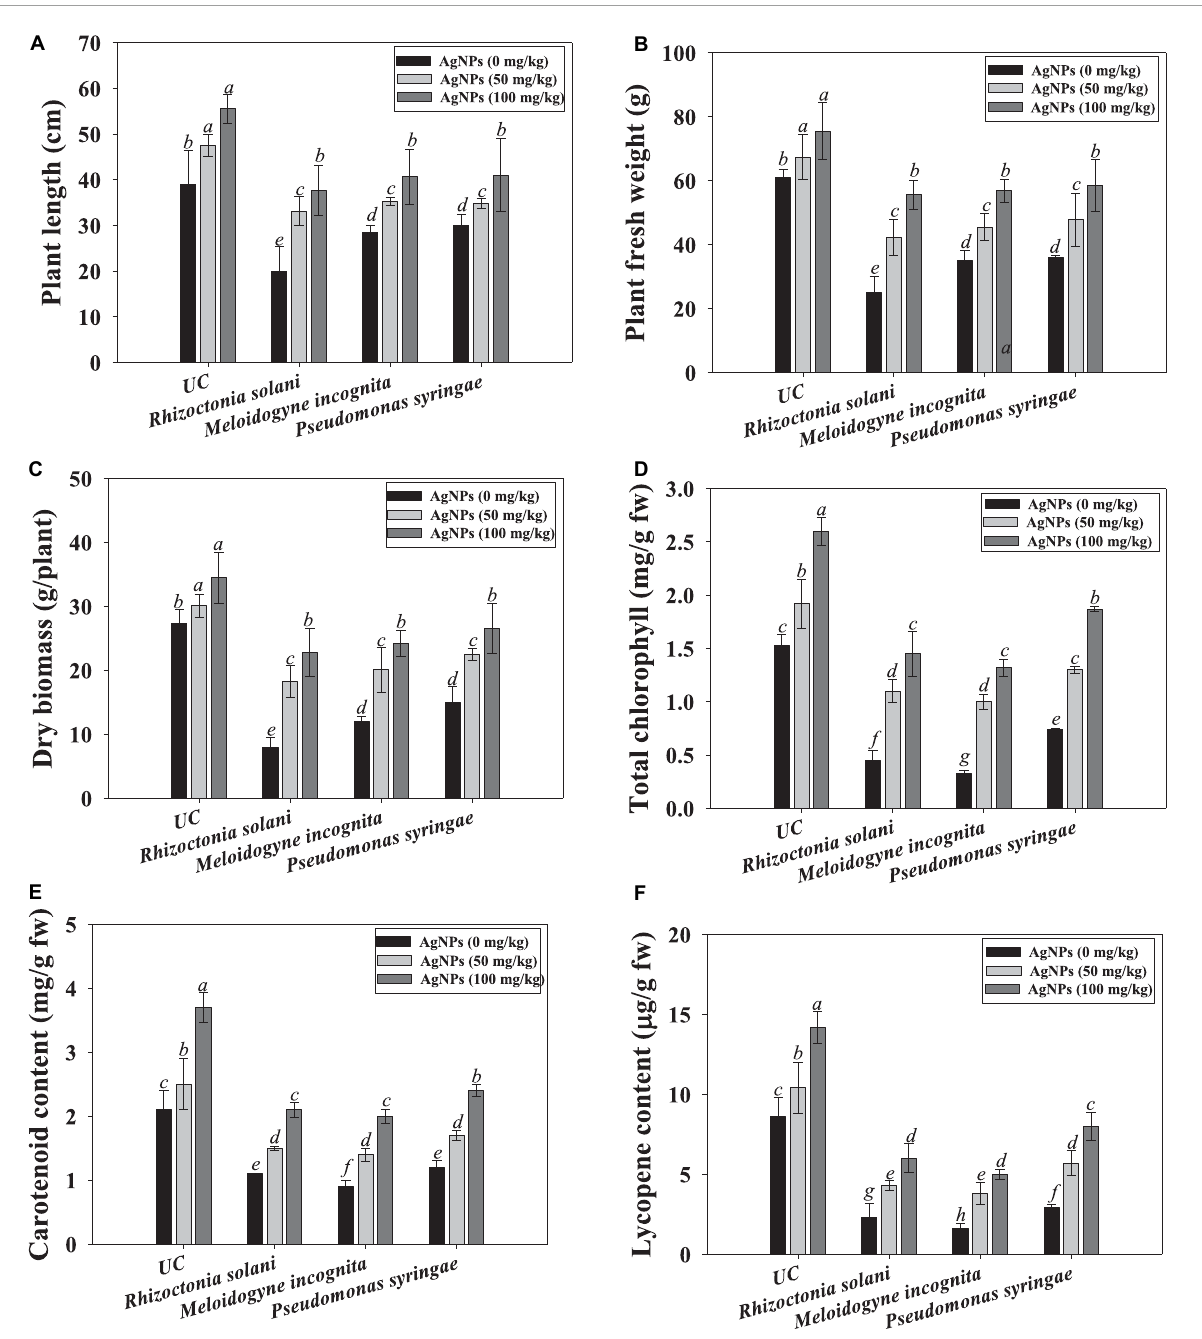
FIGURE5 Effect of Cassia fistula leaf synthesized silver nanoparticles (Ag@ Cf L-NPs) on biological and physiological parameters of tomato crop cultivated in pot-soils infected with phytopathogens; R. solani (fungi), M. incognita (root-knot nematodes) and P. syringae (bacteria): plant length (A) , fresh weight (B) , dry biomass (C) , total chlorophyll (D) , carotenoid content (E) and lycopene content (F) . In this figure, bar diagrams represents the mean values of three replicates ( n = 3). Corresponding error bars represents standard deviation (S.D) of three replicates (S.D, n =